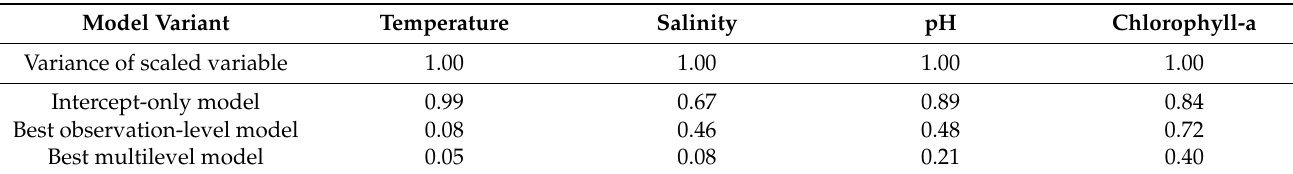
Table 6. Residual variances of the best observation-level and multilevel models for the four water property variables. Model Variant